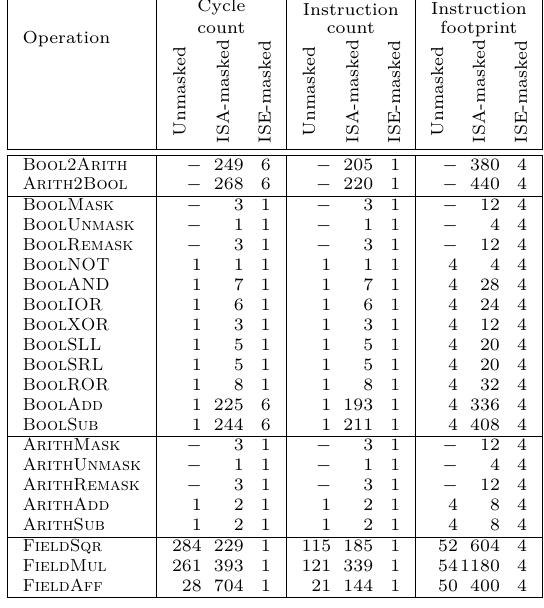
Table 3: Comparison of a) cycle count (i.e., execution latency), b) instruction count (i.e., number of instructions executed), and c) instruction footprint (measured in bytes), for both unmasked (using the base ISA) and masked (using the base ISA and ISE) variants of individual, underlying operations. Entries marked − are not applicable, e.g., because there is no need for mask or unmask operations in the unmasked variant. Note for cycle counts, we count entire rising-edge to rising-edge clock cycles: this means operations such as BoolAND which use double-pumped clocking take one cycle, despite a need for additional latching steps.